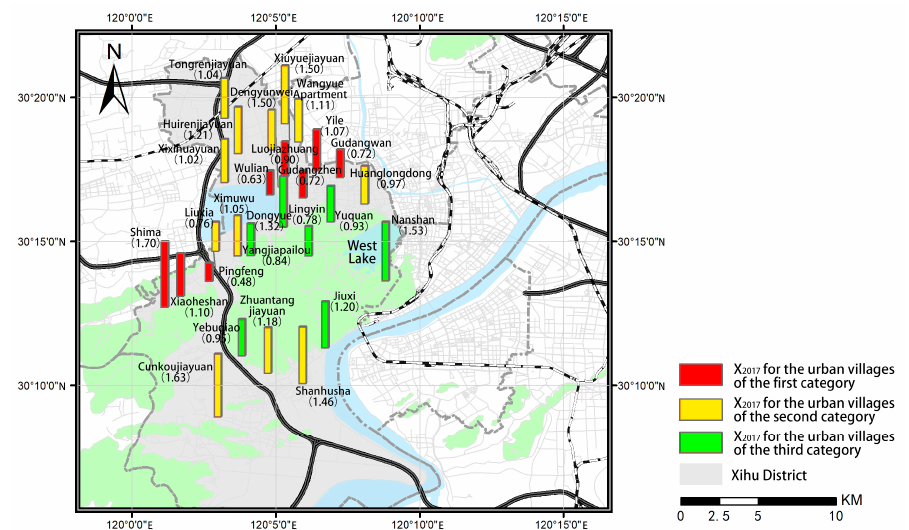
Figure 9. Spatial distribution of X 2017 for the urban villages of the three categories. The most notable difference is found in the urban villages of the first